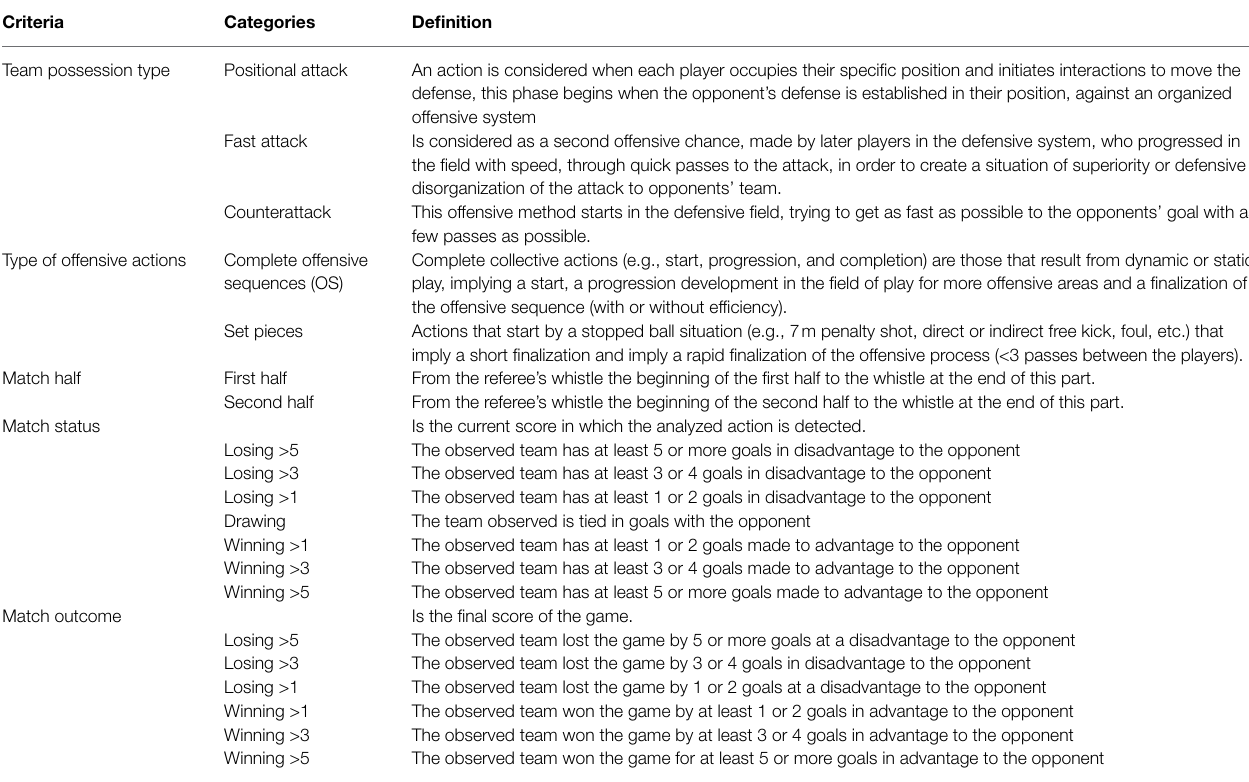
TABLE 1 | Description of variables and definitions of category used in the team match performance analysis (Team Possession Type, Type of offensive actions, Match half, Match status, Match outcome, and Numerical